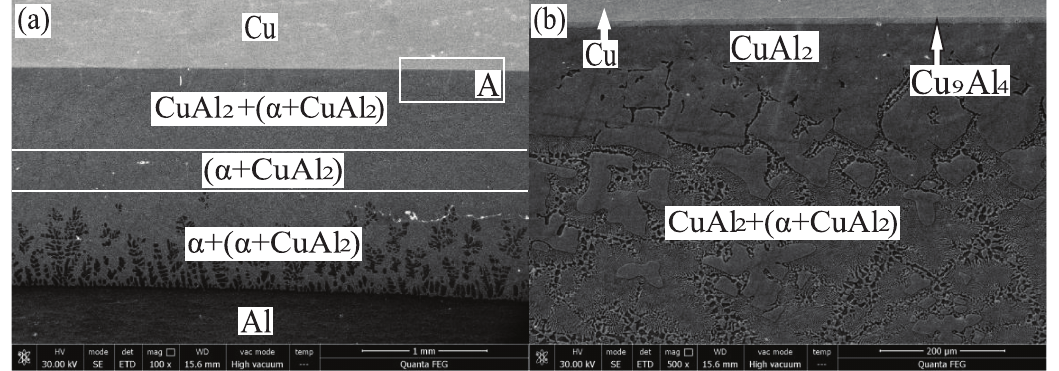
Figure 4: Microstructures of transition layer in the Cu/Al composite casting at 780°C pouring: (a) holding for 60 s, air jet cooling; and (b) enlarged photo of A region shown in Figure